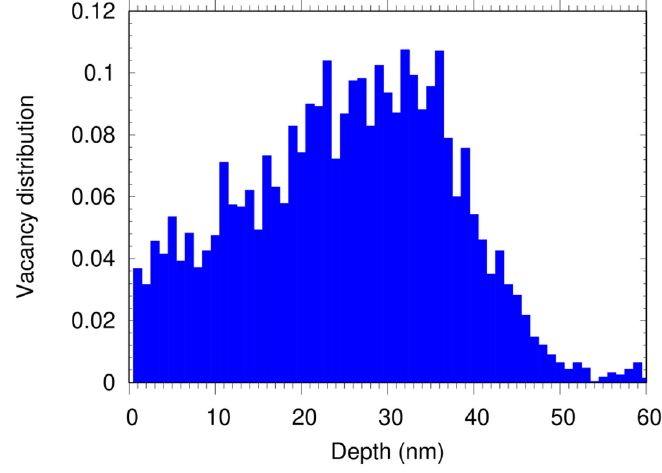
Figure 1 . SRIM simulation for the creation of vacancies by 6 keV He + ion bombardment under normal incidence. The NV centers created during the annealing process have the same depth profile.